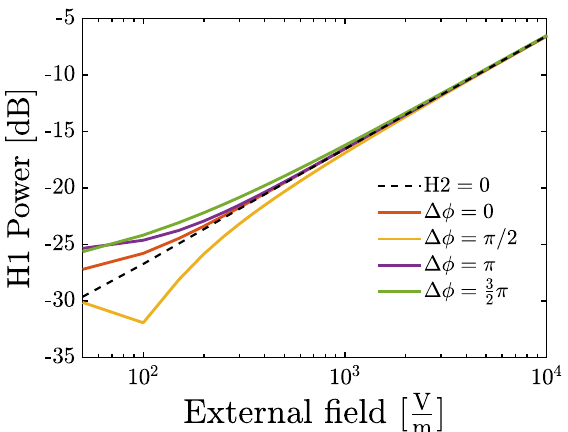
Figure 20. Impact of the spurious second harmonic amplitude on the measurement accuracy. H2 amplitude is referred to the fundamental frequency amplitude.